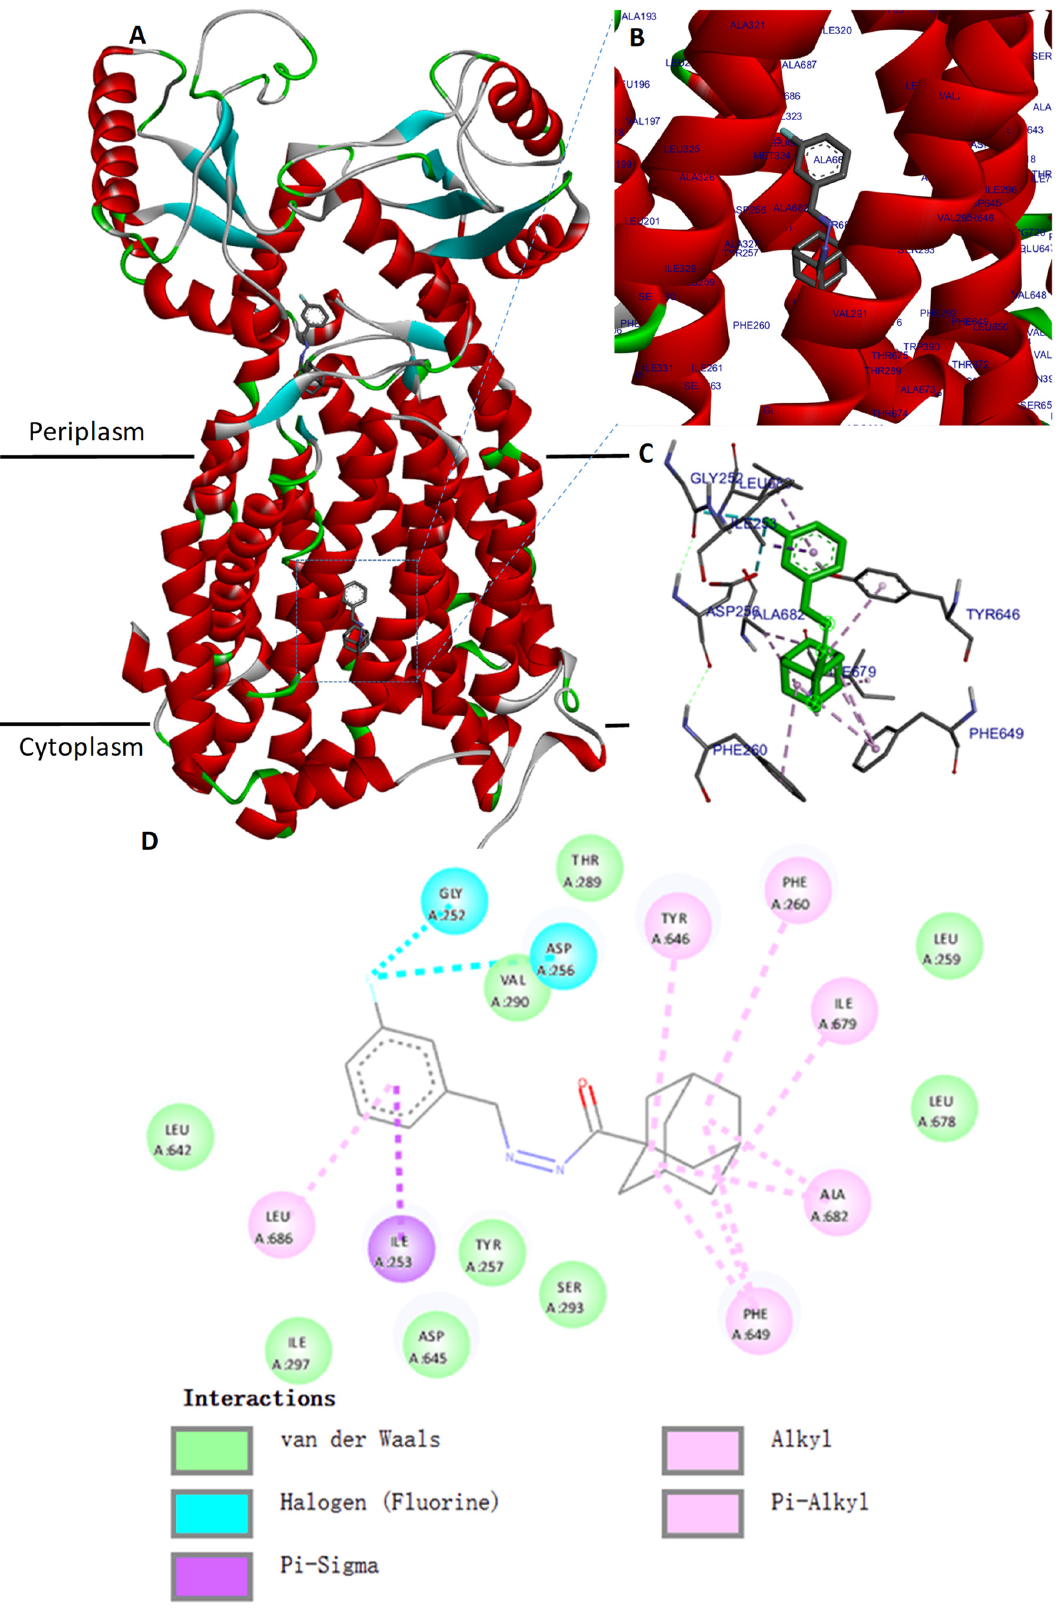
Figure 4. The docking site of compound 1 with M. smegmatis MmpL3. ( A ) Representation of an X-ray structure of the M. smegmatis MmpL3 (PDB ID 6AJH) with docked ligand compound 1 in the